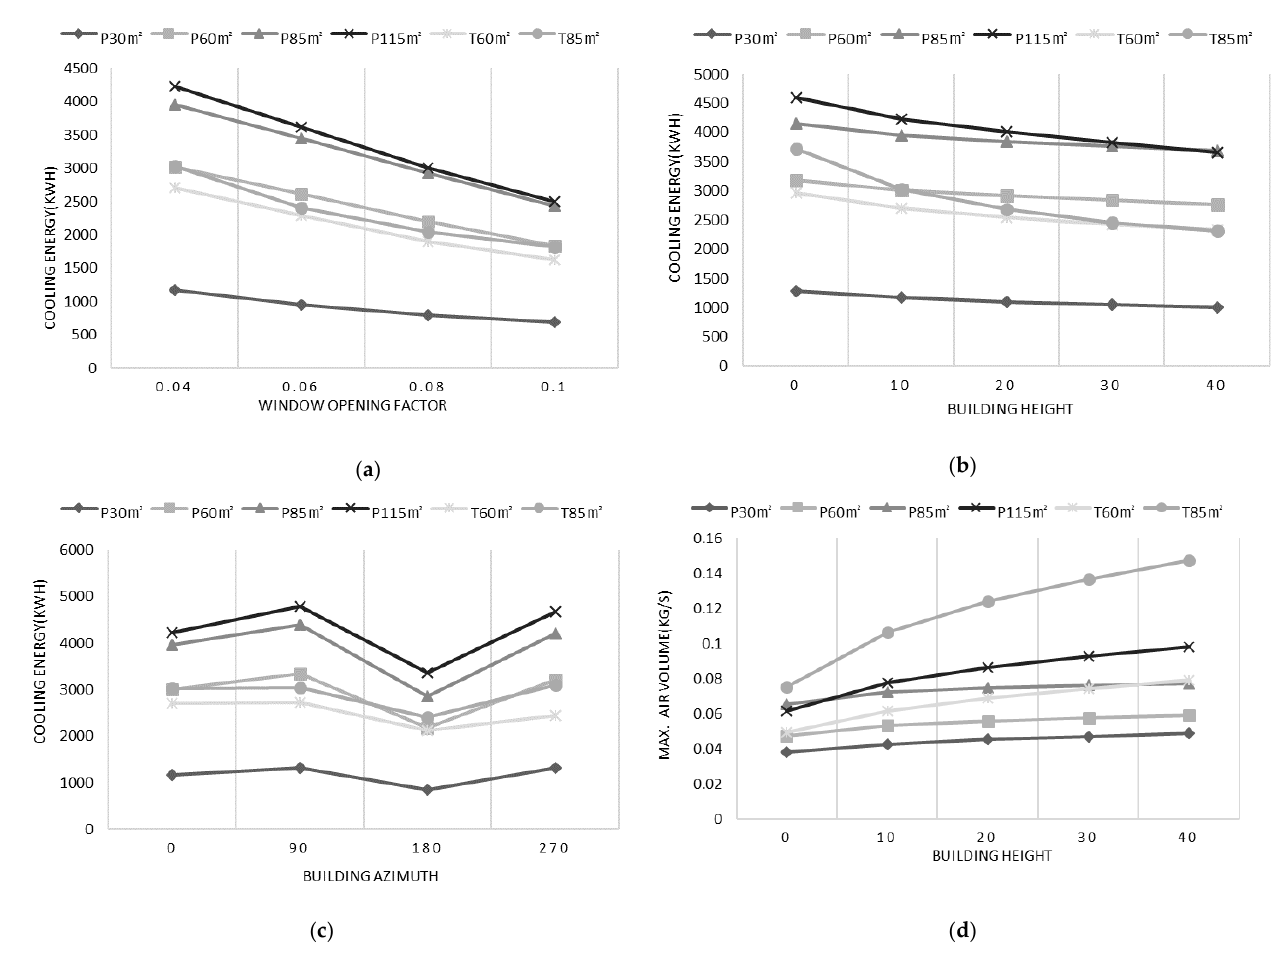
Figure 3. Comparison of hybrid ventilation results according to variable conditions. ( a ) Cooling energy according to the change in window opening factor (azimuth: 0, height: 10 m fixed). ( b ) Cooling energy according to the building height (m) (azimuth: 0, opening factor: 0.04 fixed). ( c ) Cooling energy according to the change in building azimuth (height: 10 m, opening factor: 0.04 fixed). ( d ) Max. Air ventilation volume according to the change in building height (m) (azimuth: 0, opening factor: 0.04 fixed).